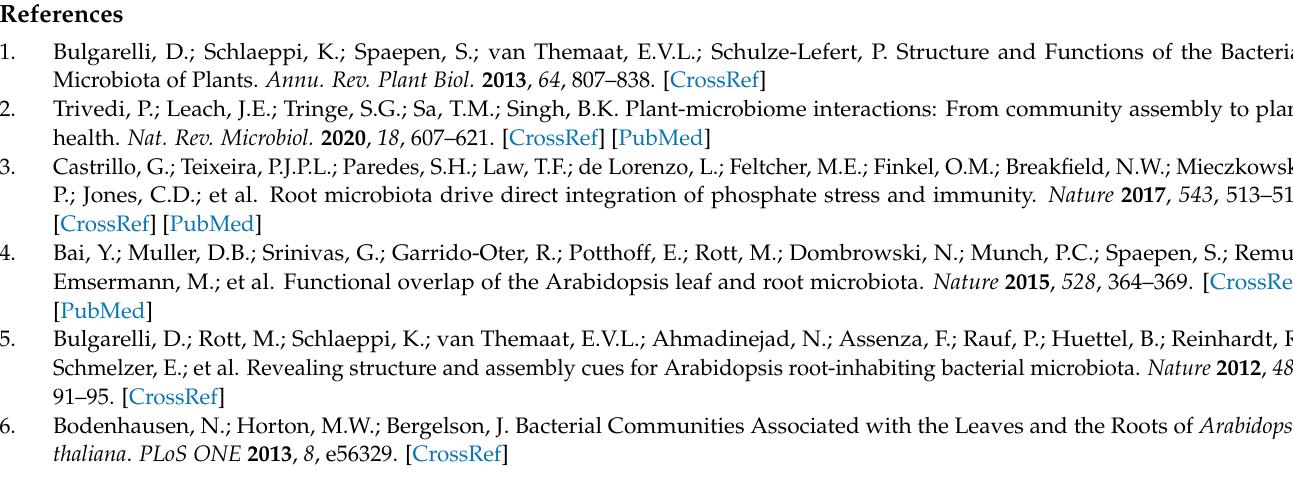
metabolism; Table S1: Summary of all the samples in this study; Table S2: Variance explained by plant genotypes; Table S3: Phylum level difference